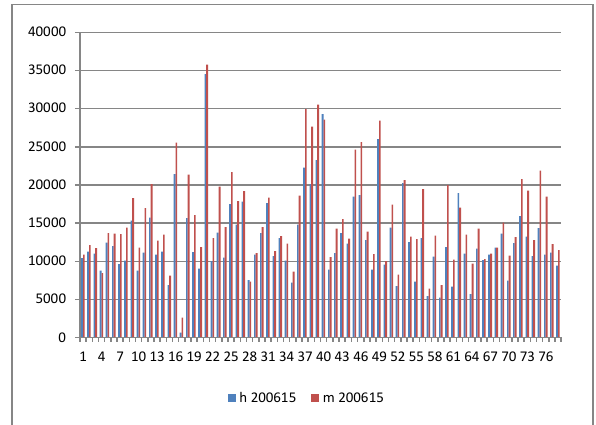
Figure 8 Comparison of hourly and minutely radiation calculation of the longest day of 2015 (radiation in Wm -2 on the vertical axis) Figure 10 Effect of Meshing to find shadow receiving point at different resolution (red is shadow)